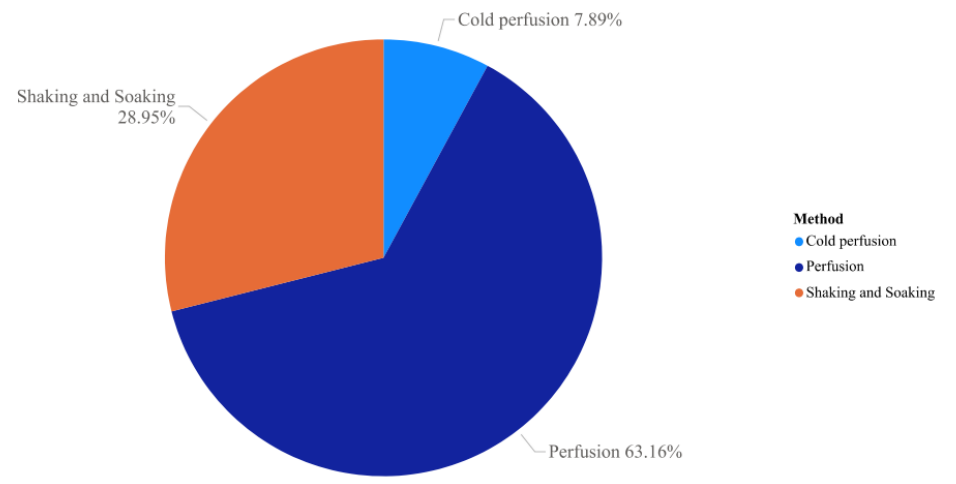
Figure 4. Physical methods used in pancreas decellularization found in the PubMed database between 2009 and 2021. The most used physical method is perfusion (63.16%), followed by agitation and immersion (28.95%) which is classified as a mechanical protocol and cold perfusion (7.89%) that uses temperature to assist in the process.